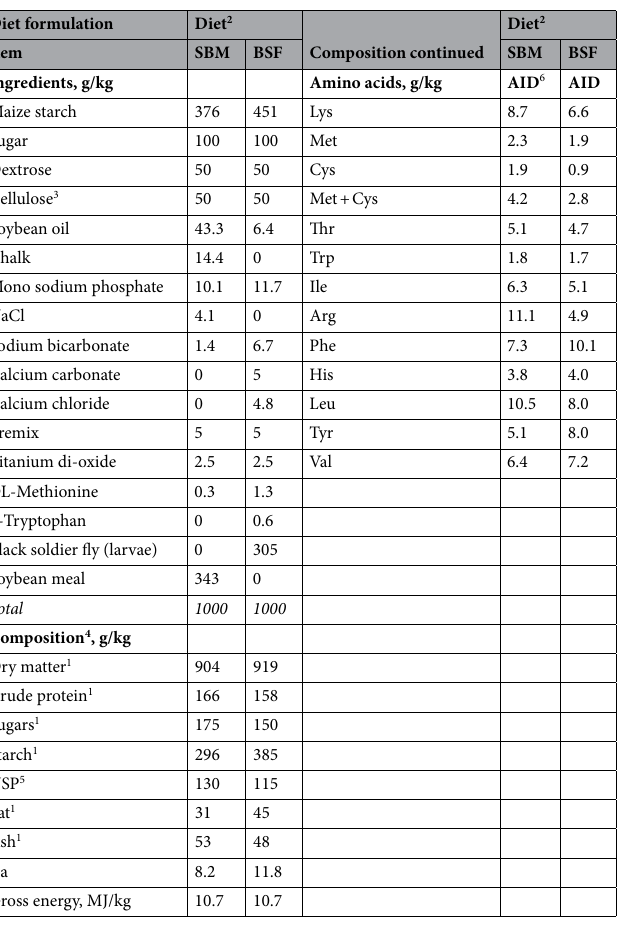
Table 3. Ingredient and calculated or analysed 1 nutrient composition of the experimental diets for pigs, as fed basis. 1 Analysed nutrient compositions. 2 Diet: SBM is soybean meal, and BSF is black soldier fly larvae meal. 3 Arbocell (JRS, Germany). 4 Diets composition were formulated using data on ingredient nutrient composition and nutrient digestibility coefficients according to the Central Bureau for Livestock Feeding (CVB, Lelystad, the Netherlands). 5 Non-starch polysaccharides. 6 Apparent ileal digestibility,